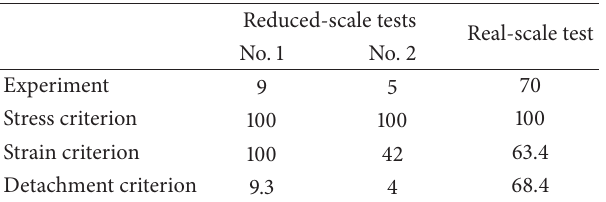
Table 1: Comparison of RIS (%) obtained in tests and using different criteria for ice